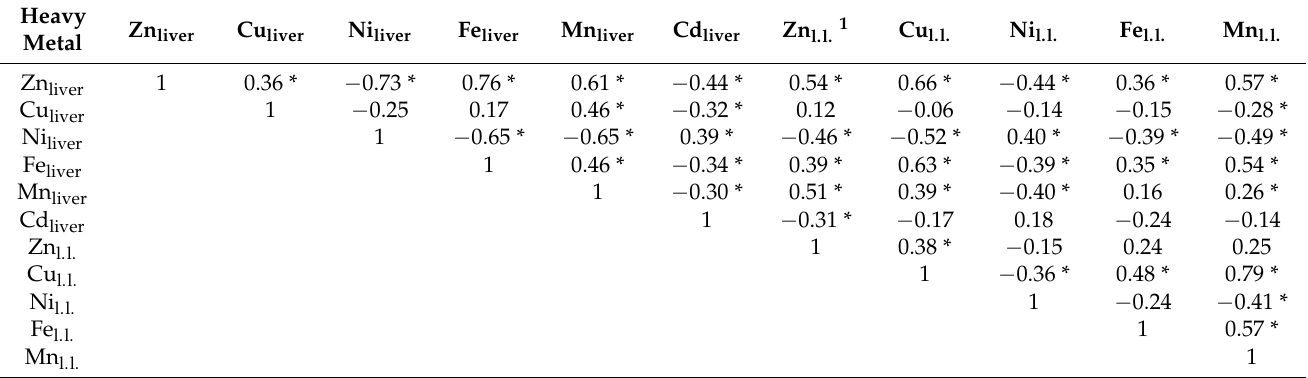
Table 5. Phenotypic correlations between metals in the liver and meat (m. longissimus